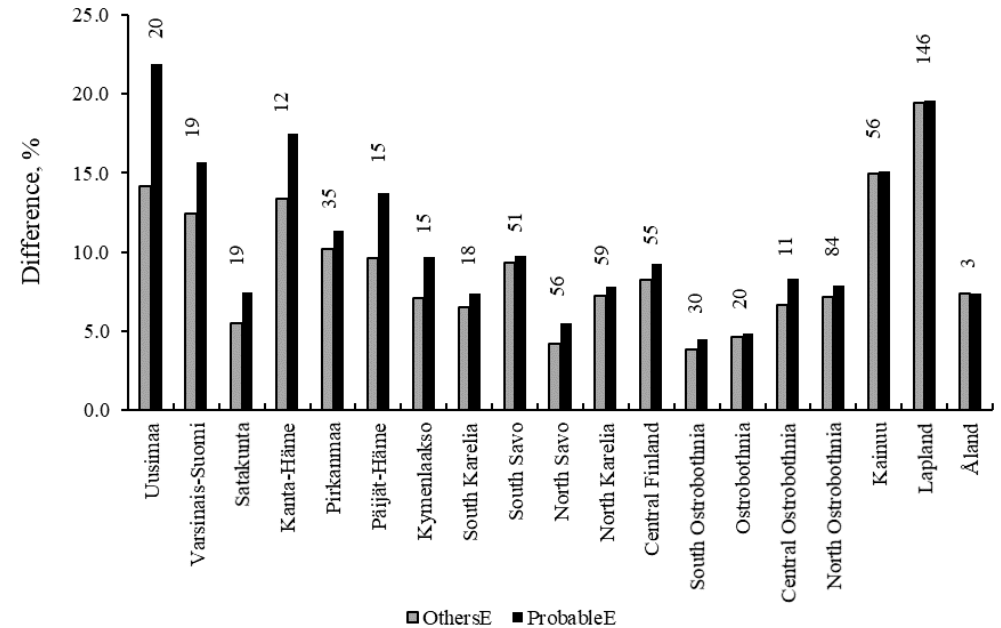
Figure 5. Estimated difference (%) in carbon stock of living tree components in OthersE and ProbableE compared to WRE for the provinces in Finland in 2025. The numbers above the bars represent the carbon stock (million tons) in forest land and poorly productive forest land in WRE in 2025.